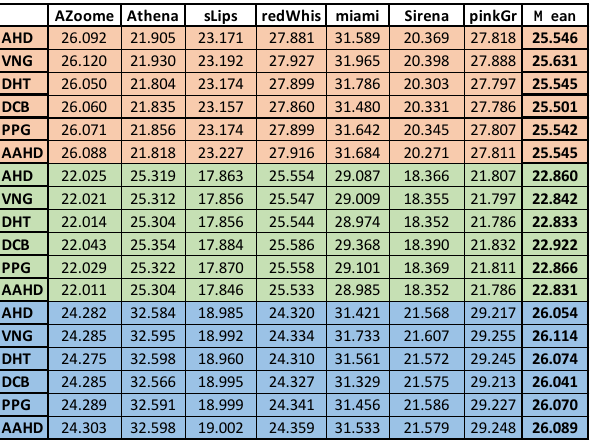
Figure 9: Standard Deviations of the Differences in radiometric values for Red, Green and Blue of the 6 De- mosaicking algorithms for every